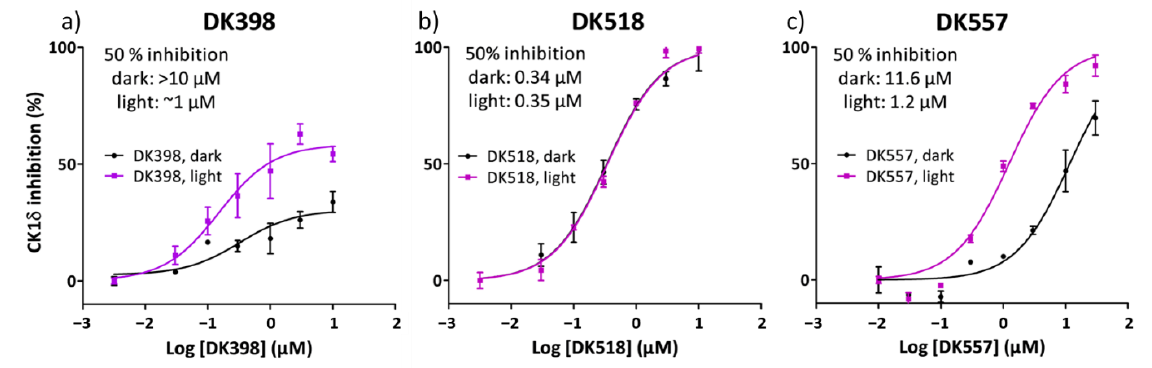
Figure 3. Dose–response curves displaying a degree of CK1 δ inhibition for ‘dark’ (black) and irradiated samples (purple, ‘light’) of the photoswitchable inhibitors ( a ) DK398 , ( b ) DK518 , and ( c ) DK557 . ‘Light’ samples were irradiated with UV light ( λ max = 365 nm) for the full duration of the assay (2 h). Shown are averages and standard deviations of triplicate